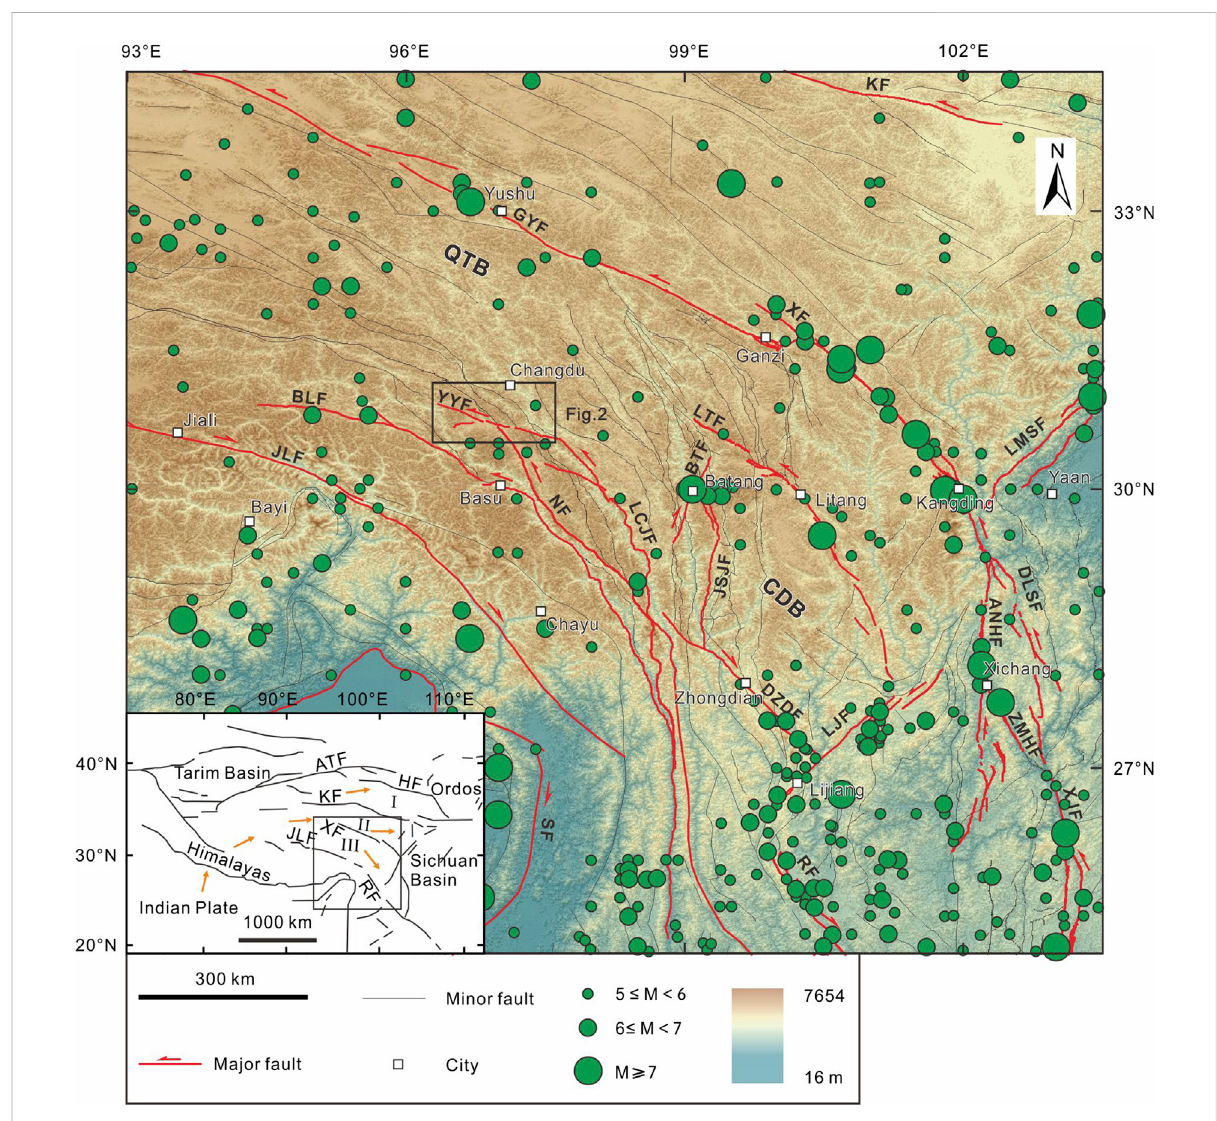
FIGURE 1 Regional tectonics and seismicity in southeastern Tibet. The red lines are major active fault traces. The green circles of different sizes indicate epicenters of earlier documented (historical and instrumental) earthquakes. The small white rectangles denote cities. The black rectangle indicates the study area of the YYF. QTB, Qiangtang block; CDB, Chuandian block. The hillshade map is generated from the Advanced Spaceborne Thermal Emission and Re fl ection Radiometer (ASTER) Global Digital Elevation Model (ASTGTM) (90-m resolution). Index map showing major boundary faults and blocks on the Tibetan Plateau. The orange arrows indicate the block motion direction according to GPS data (Gan et al., 2007). Blocks: I, Qaidam-Qilian block; II, Bayan Har block; III, Qiangtang-Chuandian block. Abbreviations of theactive faults: ATF, Altyn Tagh fault; HF, Haiyuan fault; XF, Xianshuihe fault; JLF, Jiali fault; RF, Red River fault; BLF, Bianba-Luolong fault; YYF, Yangda-Yayu fault; NF, Nujiang fault; LTF, Litang fault; LCJF, Lancangjiang fault; JSJF, Jinshajiang fault; BTF, Batang fault; LMSF, Longmenshan fault; DLSF, Daliangshan fault; ANHF, Anninghe fault;